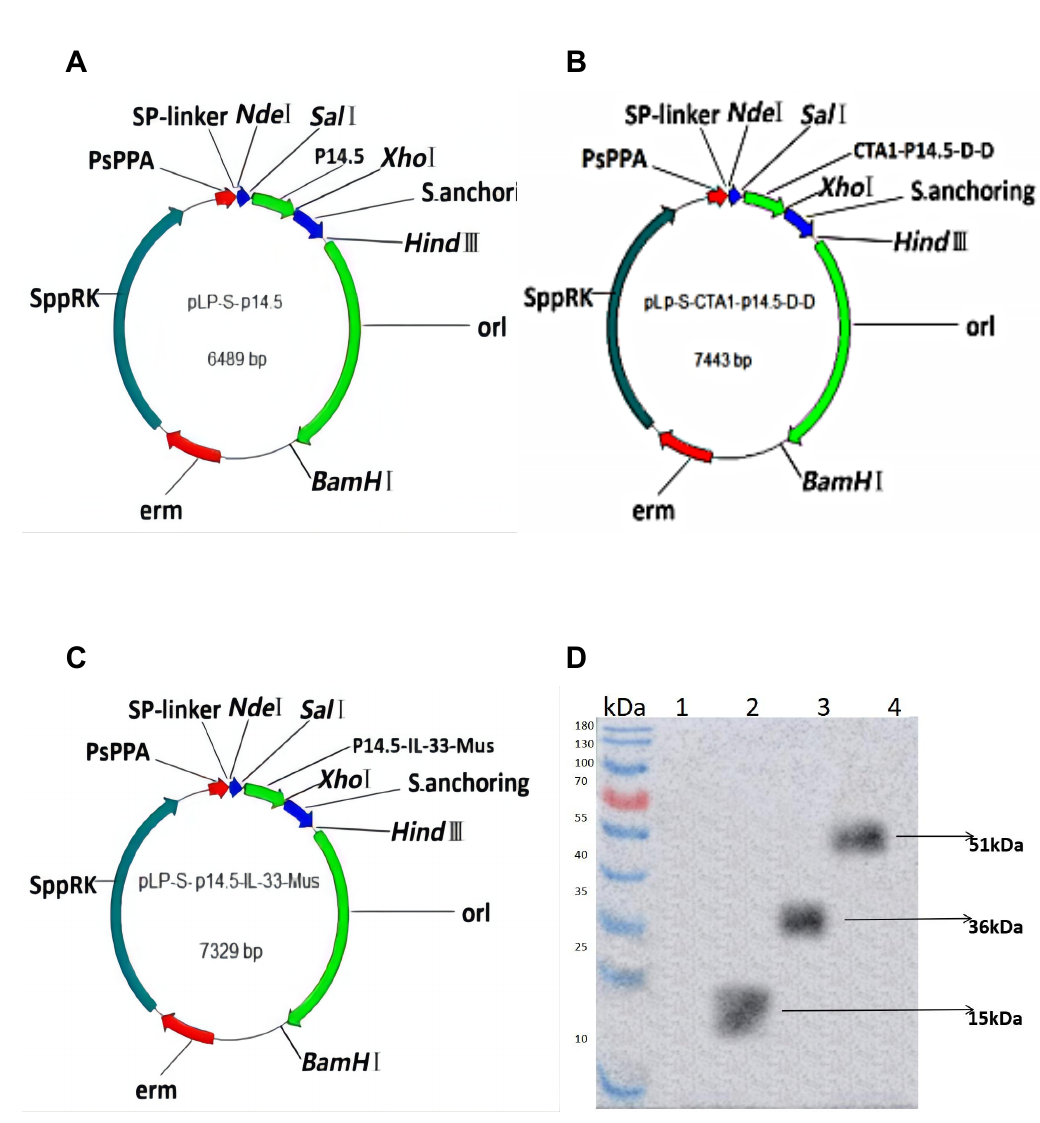
Figure 1. ( A ) A map of the plasmid NC8-pLP-S-p14.5,the plasmid size is 6489 bp; ( B ) A map of the plasmid NC8-pLP-S-p14.5-IL-33-Mus, the plasmid size is 7443 bp; ( C ) A map of the plasmid NC8-pLP-S-CTA1-p14.5-D-D, the plasmid size is 7329 bp; ( D ) The expressions of the